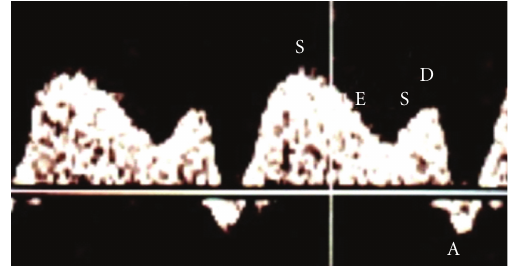
Figure 1: Spectrum of blood velocities in right hepatic vein: S = ventricular systole, ES = end-systole, D = peak diastolic velocity, and A = atrial contraction in late